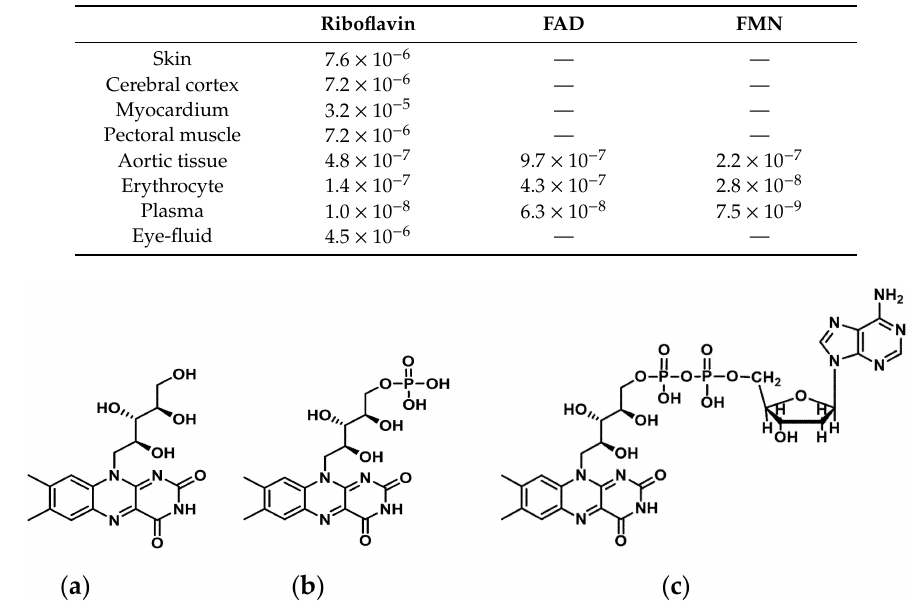
Table 1. Flavin content of selected human body fluids (mol L − 1 ) and organs (mol per kg of dry matter) [1].